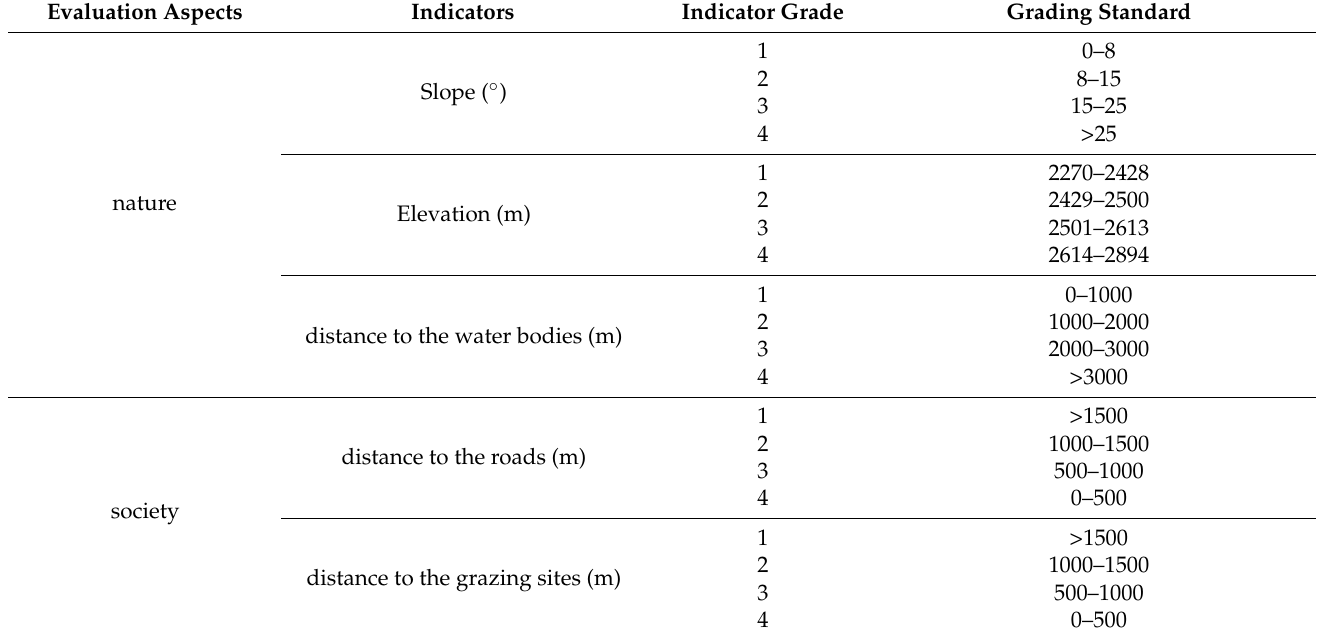
Table 2. The evaluation factors used to determine landscape ecological